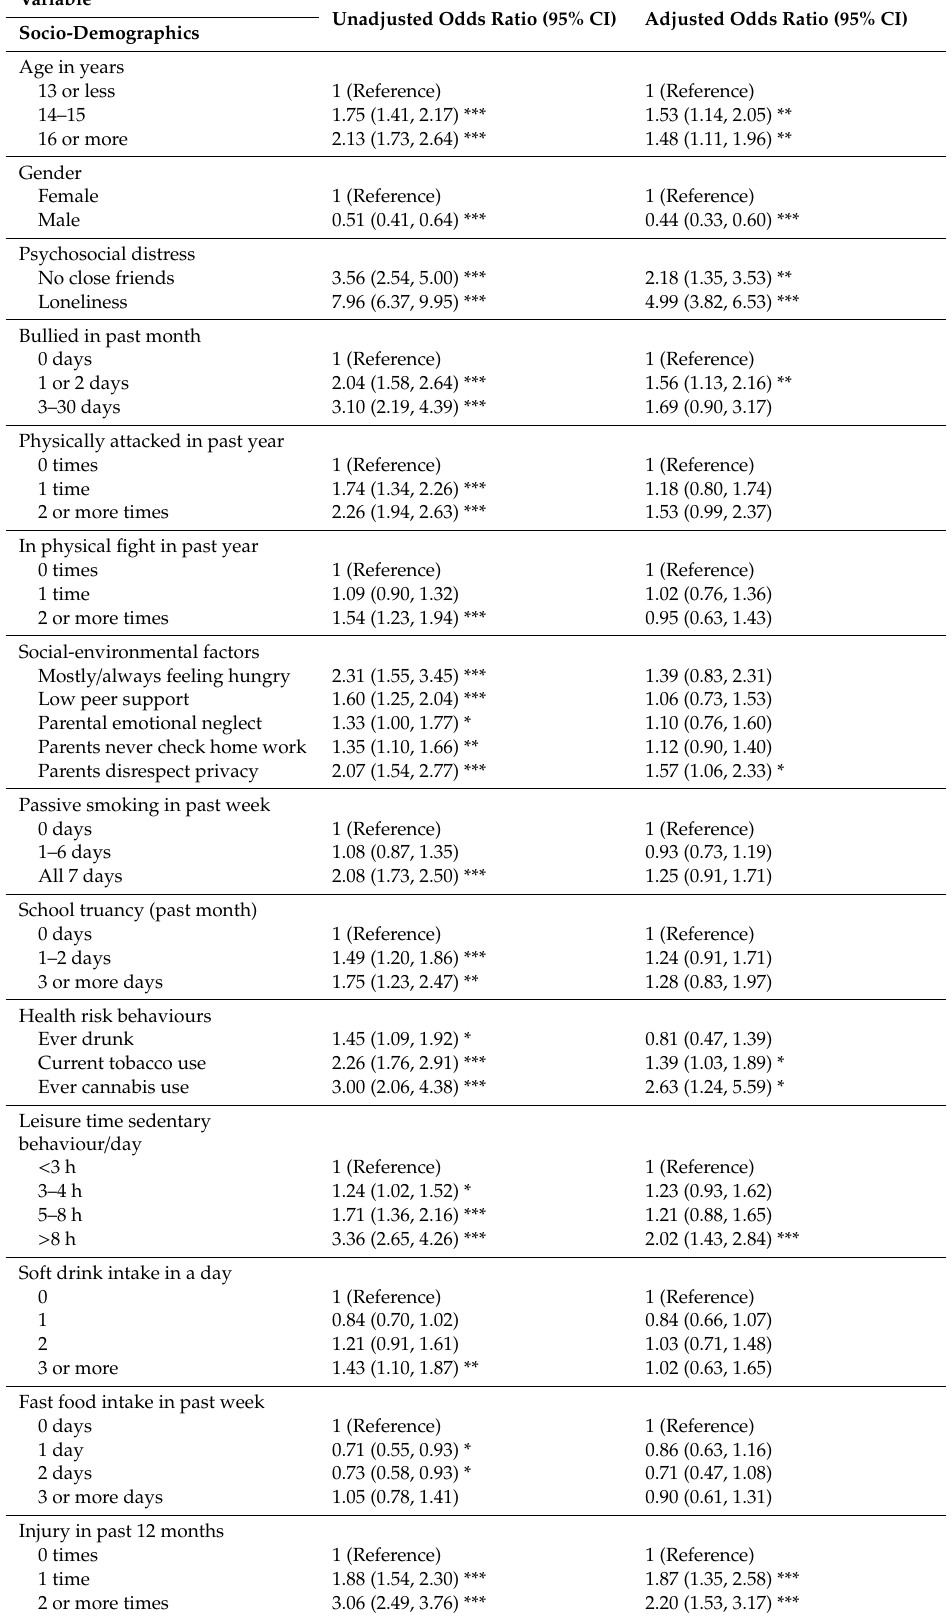
Table 2. Associations with worry-induced sleep